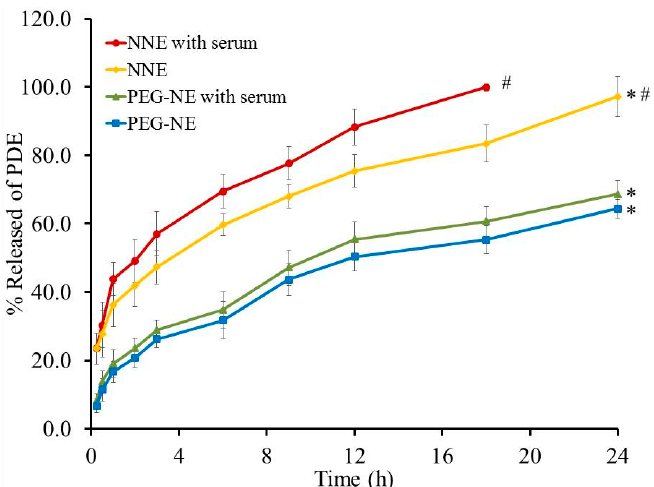
Figure 9. Study of DPE in vitro release from NE formulations before and after serum incubation. Results are stated as the mean with the bar showing S.D. ( n = 3). * p < 0.05 if compared to NNE with serum. # p < 0.05 if compared to PEG ‐ NE with serum.